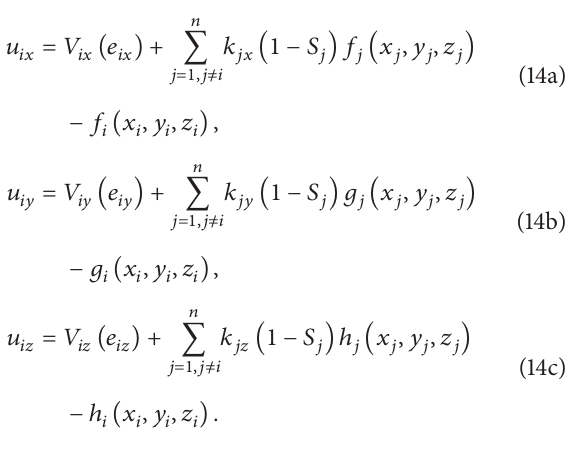
𝑆 𝑗 is either zero